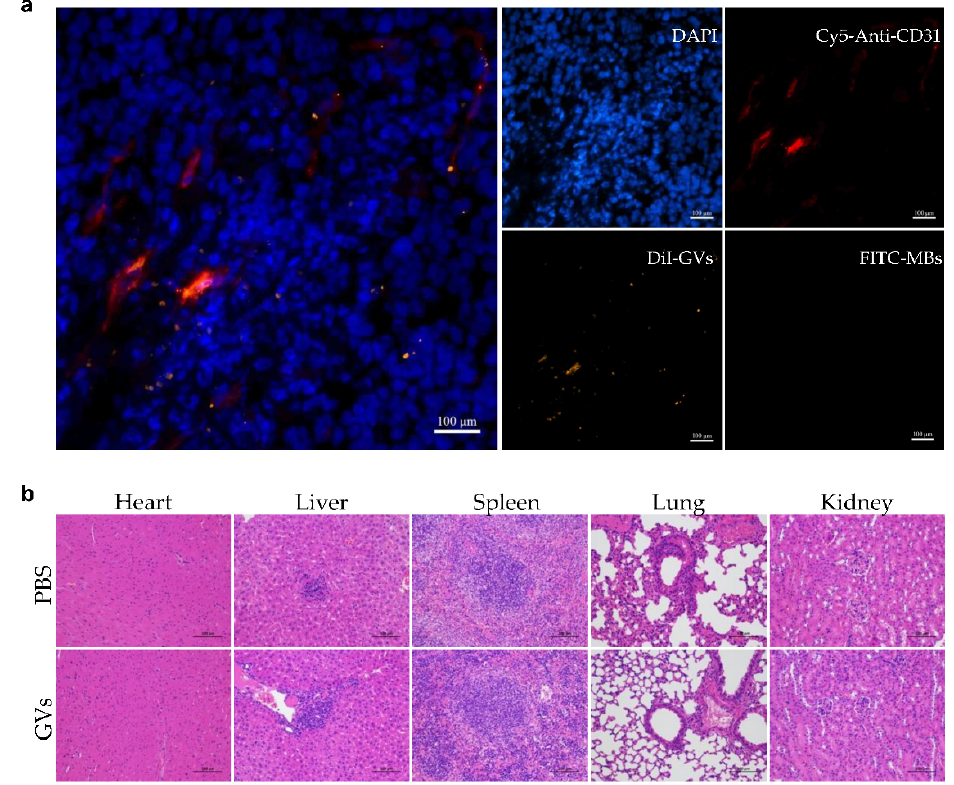
Figure 6. ( a ) Inverted fluorescent microscope images of tumor sections after nuclear and vessel labeling. Red stands for CD31 stained vessels, brown for DiI labeled GVs, and blue for DAPI stained nuclei. The scale bar is 100 μ m; ( b ), H&E staining of major organs (heart, liver, spleen, lung, and kidney) of mice treated by GVs at OD 500 3.0 or PBS.